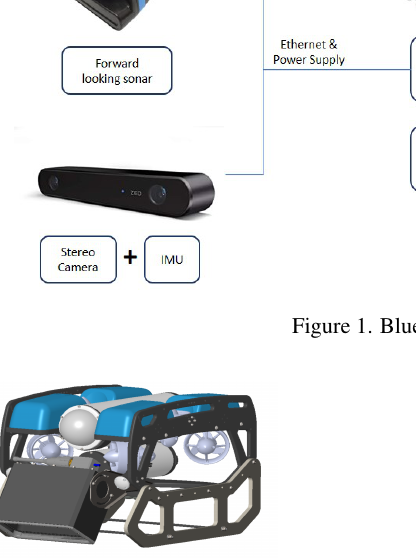
Figure 2. ZED2 waterproof housing installed on the BlueROV2 The optical sensor chosen is the StereoLab’s ZED2 stereo camera 6 . This off-the-shelf device combines two synchronised high resolution cameras and an Inertial Motion Unit (IMU).